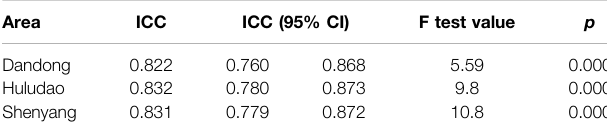
TABLE 2 | ICC and F test of the three study areas.